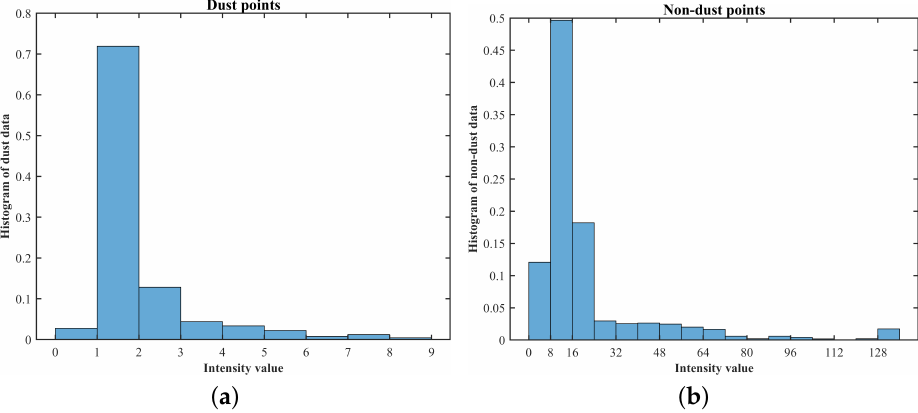
Figure 3. Histogram of VLP-16 LiDAR point clouds when exposed to dust: histogram of dust points as a percentage of total dust points ( a ) and histogram of non-dust points as a percentage of total non-dust points ( b